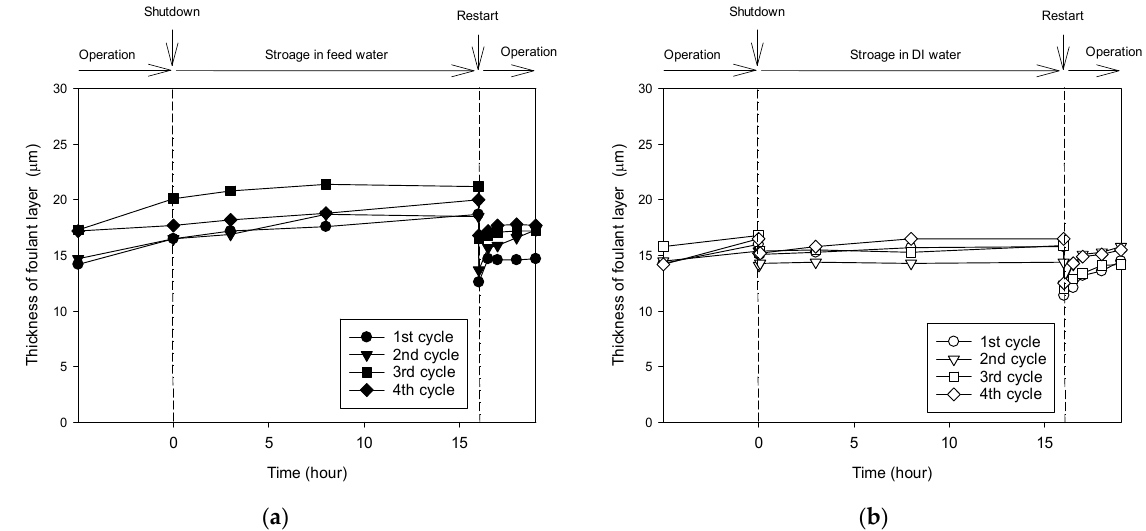
Figure 9. Changes in the foulant layer thickness in the intermittent operating cycle. ( a ) RO operation with membrane storage in the feed water (Case 2). ( b ) RO operation with the membrane storage in DI water (Case 3).